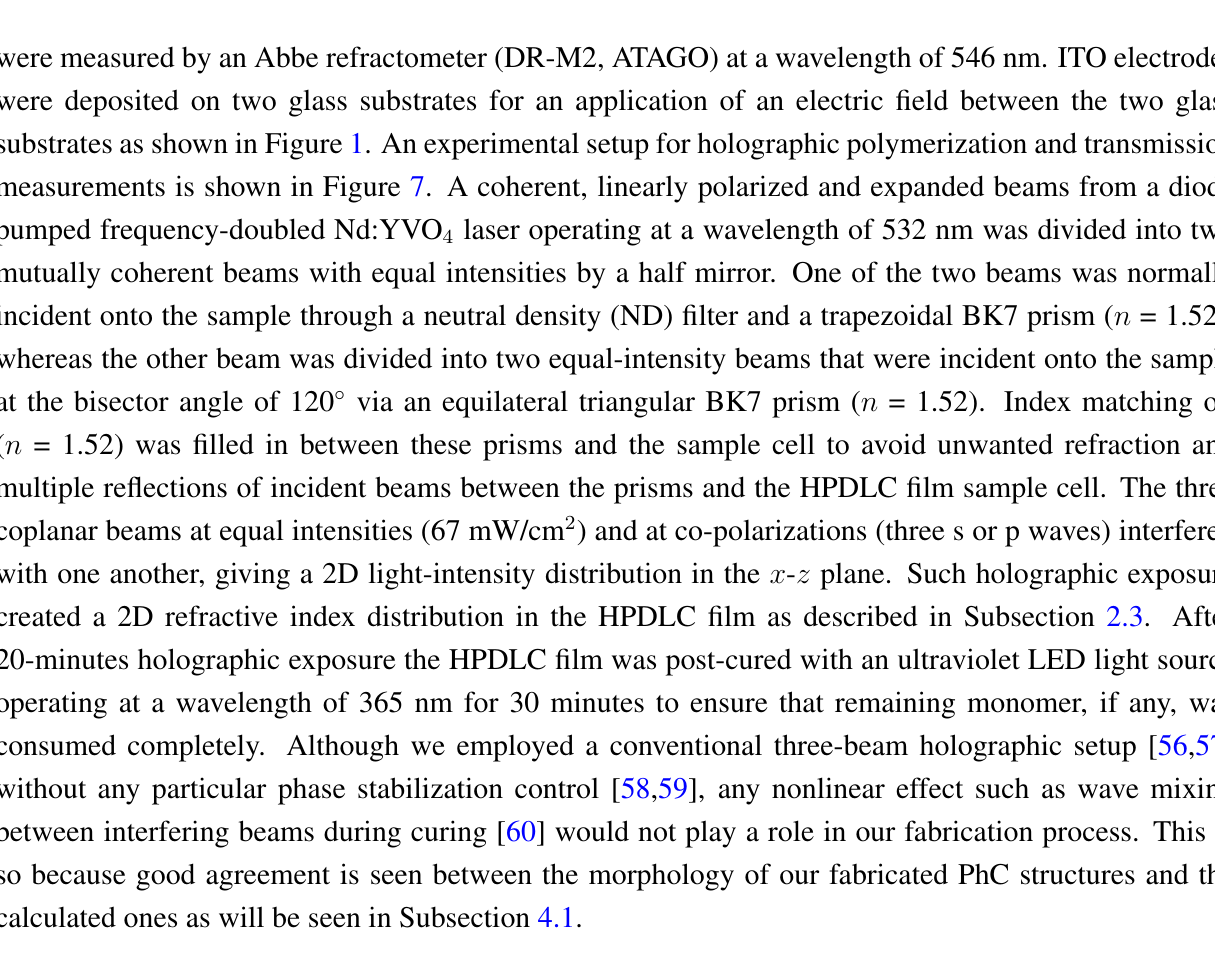
Figure 7. Experimental setup for three-beam interference holographic